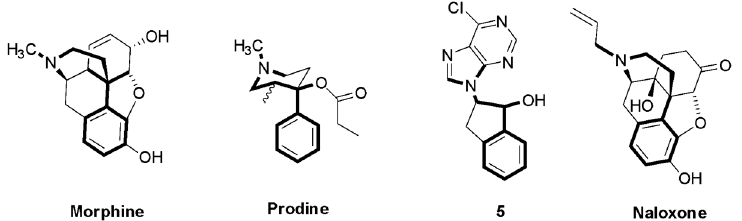
Figure 6. Structures of morphine, prodine, naloxone, and compound 5 showing the pharmacophore group in bold letters.